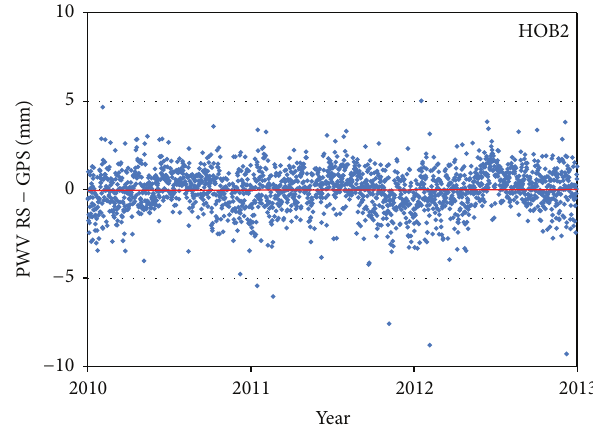
Figure 3: PWV differences (mm) between radiosonde and GPS estimates. Positive values indicate that the radiosonde observations are “more moist” than GPS. A fitted linear regression line is denoted by the red solid line and is close to zero.